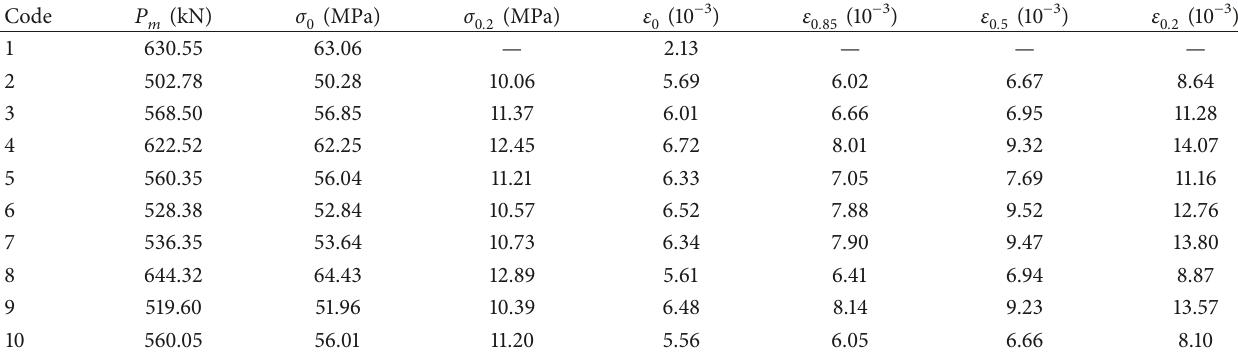
Table 3: Characteristic points of HDC stress-strain